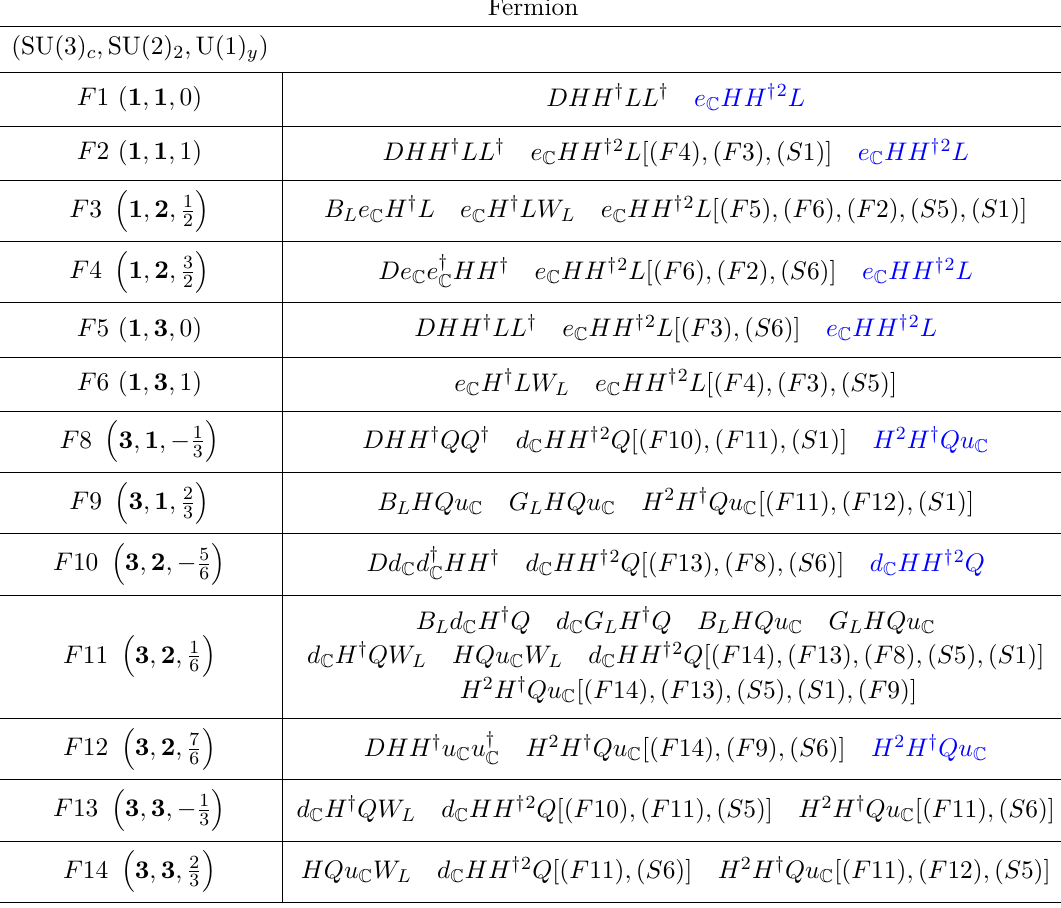
Table 16 . Fermion resonances which could generate the dim-6 operators. The name of the reso- nances is organized by the gauge quantum number. The resonance appeared in the squared bracket of the operator indicate that both resonances are needed to generate such